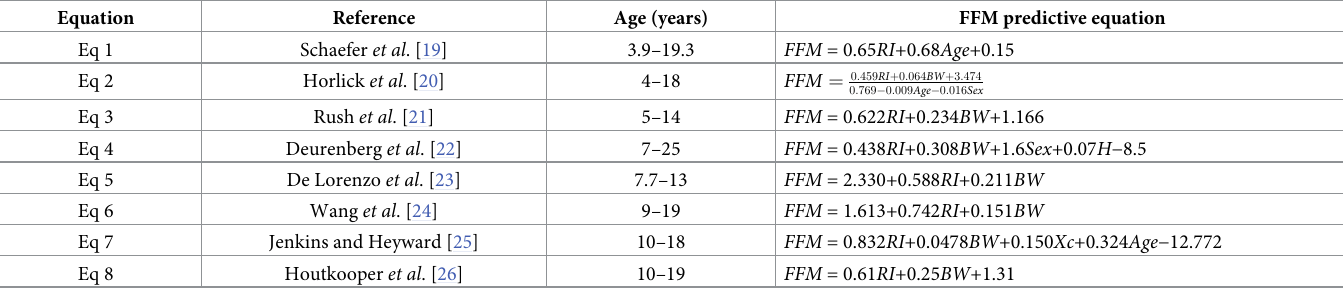
Table 1. Fat-free mass (FFM) predictive equations based on bioelectrical impedance validated for healthy children and adolescents.